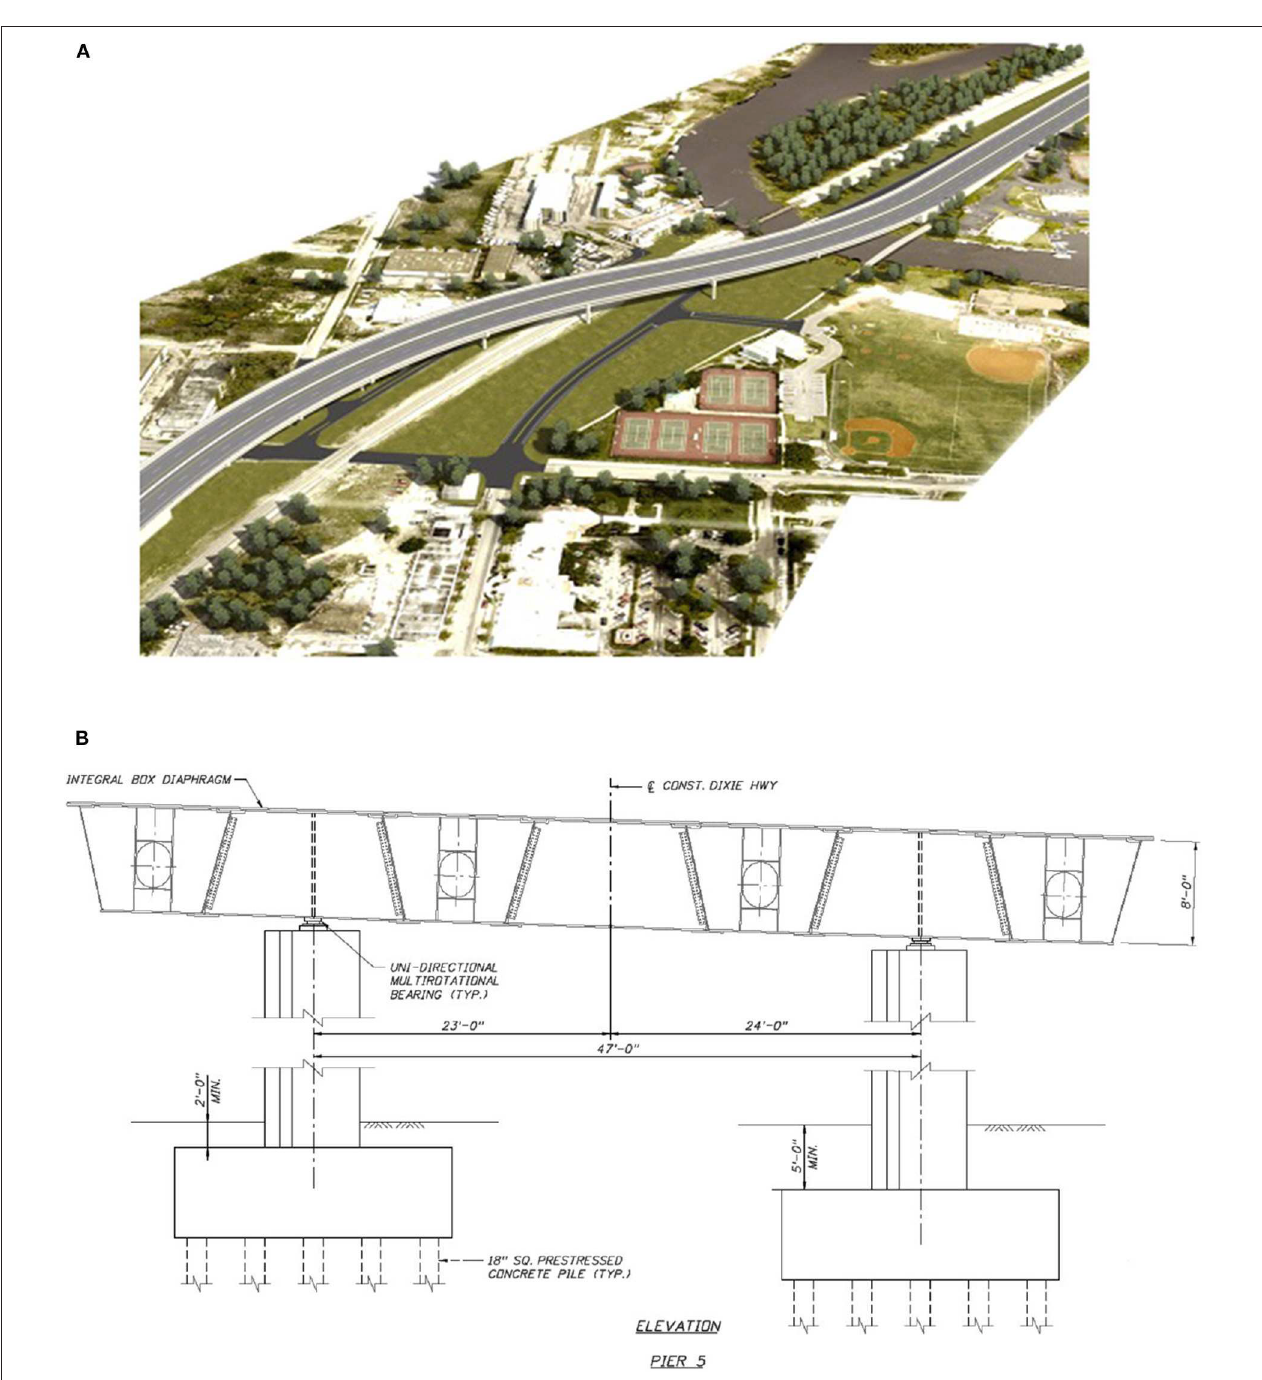
FIGURE 6 | Typical superstructure/substructure configuration (A) rendering and (B) bridge elevation.